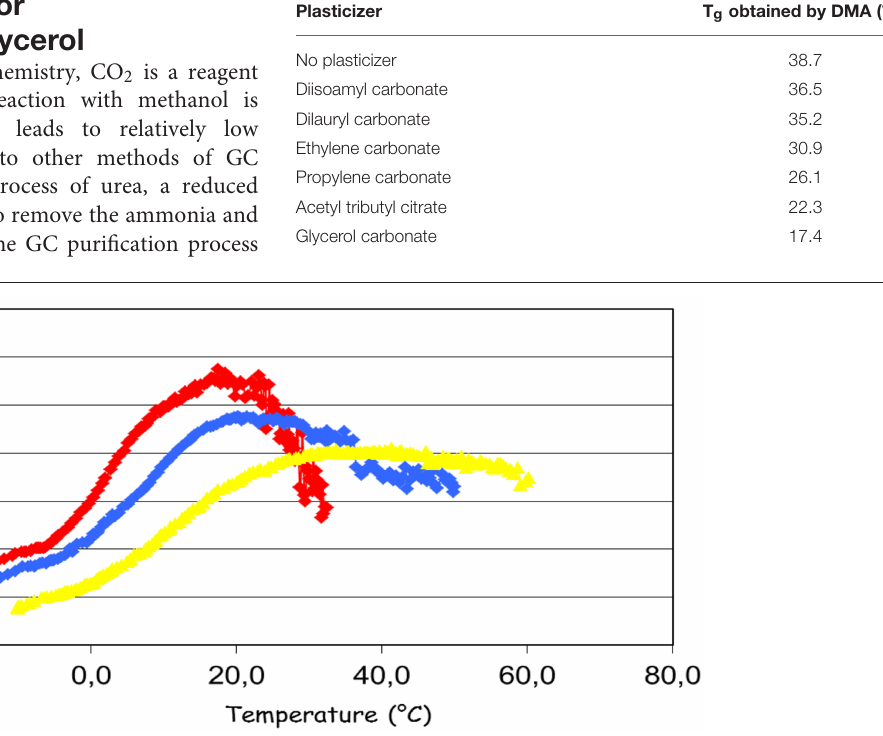
FIGURE 9 | Effect of plasticizers on glass temperature of nitrocellulosic films. Tg = 17.4 ◦ C no plasticizer (red line); Tg = 22.3 ◦ C with addition of acetyl tributyl citrate (blue line); Tg = 38.7 ◦ C with glycerol carbonate addition (yellow line).